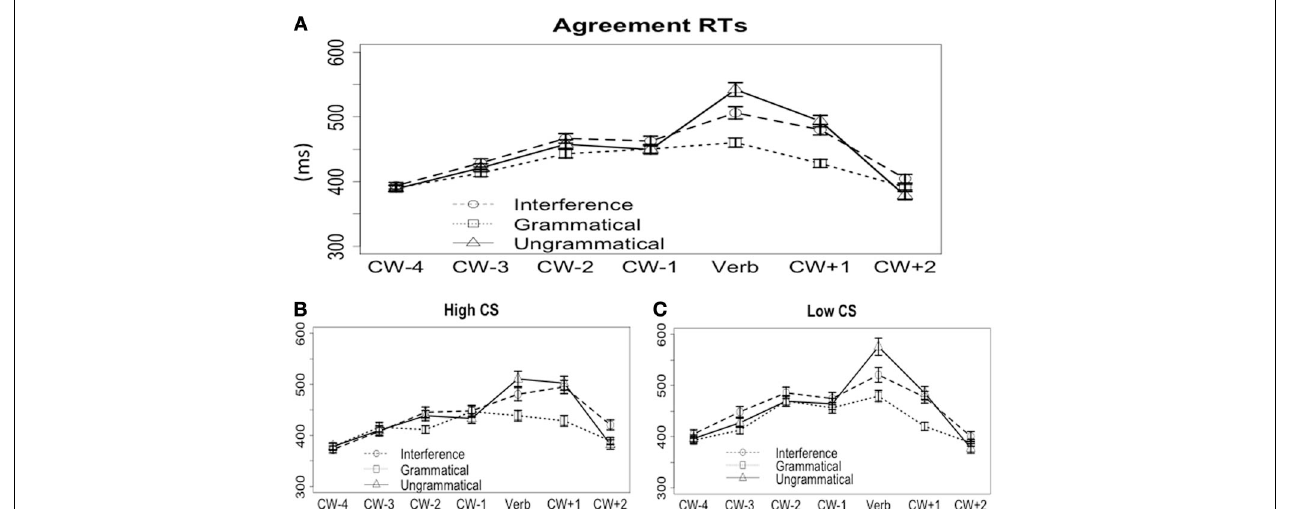
FIGURE 8 | Reading times for the agreement set of the stimuli. (A) Word-by-word reading times across all subjects. (B) Word-by-word reading times for the high CS group. (C) Word-by-word reading times for the low CS